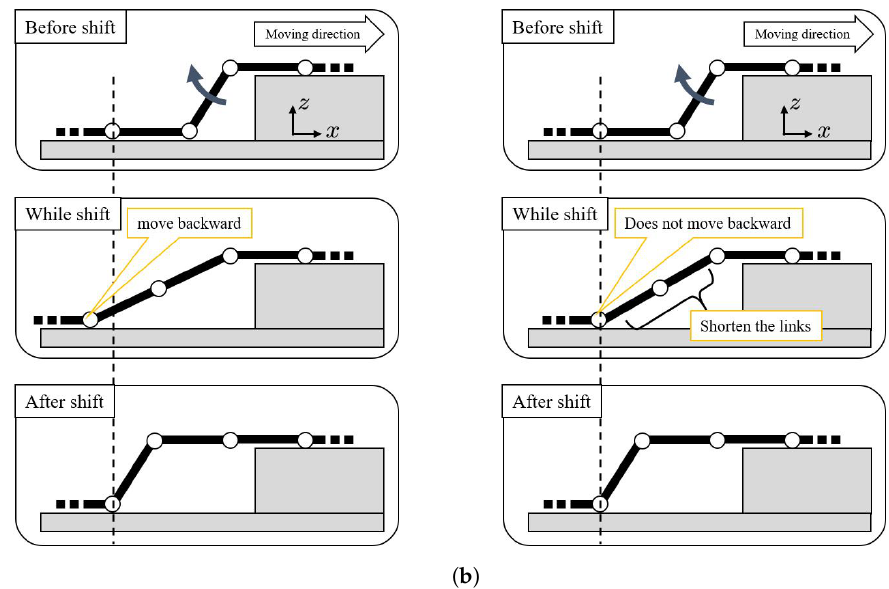
Figure 4. Shift motion in [10] and this paper. ( a ) Link length is fixed [10]. ( b ) Link length can be changed (this